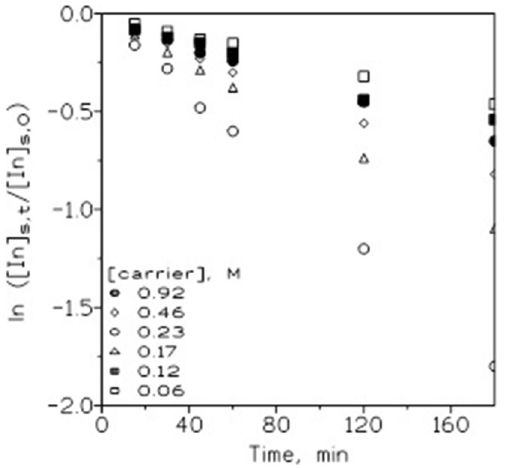
Figure 2. Influence of the carrier concentration on In(III) transport. Source phase: 0.01 g/L In(III) in 1 M HCl. Membrane phase: different concentrations of the ionic liquid in Solvesso 100 in GVHP4700 supports. Receiving phase: 0.1 M HCl.